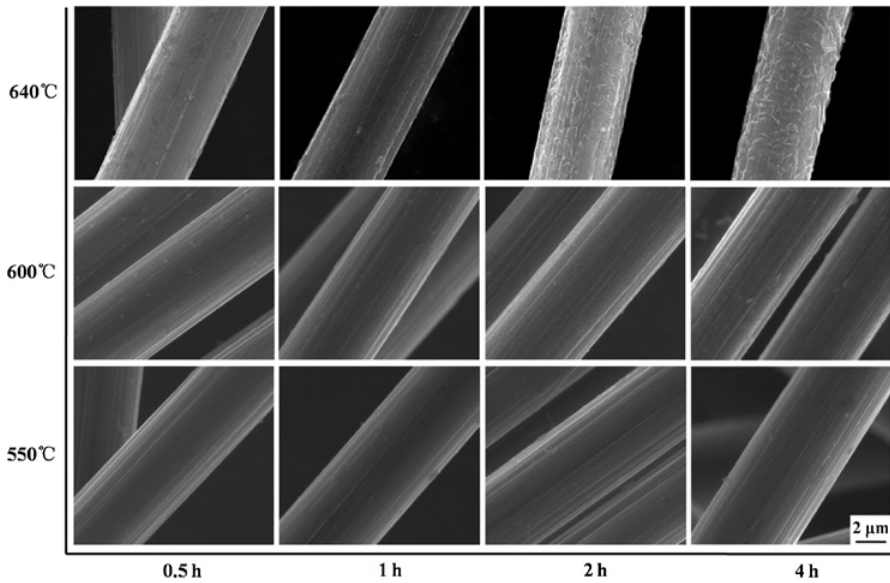
/Al composites by f